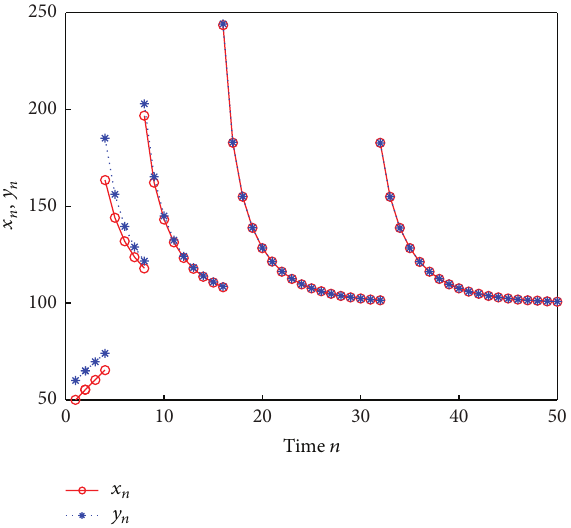
Figure 2: Global attractivity of system (1) with initial conditions = 50 and 𝑦 = 60 𝑥 0 0